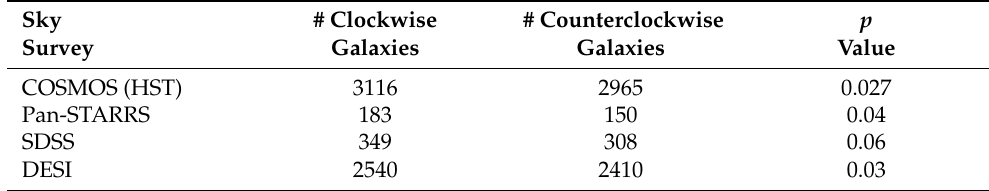
Table 8. The distribution of clockwise and counterclockwise galaxies in the HST COSMOS field, and in the larger field around COSMOS in SDSS, Pan-STARRS, and DESI Legacy Survey. The P values are the one-tail accumulated binomial distribution probabilities when the probability of a galaxy spinning in a certain direction is